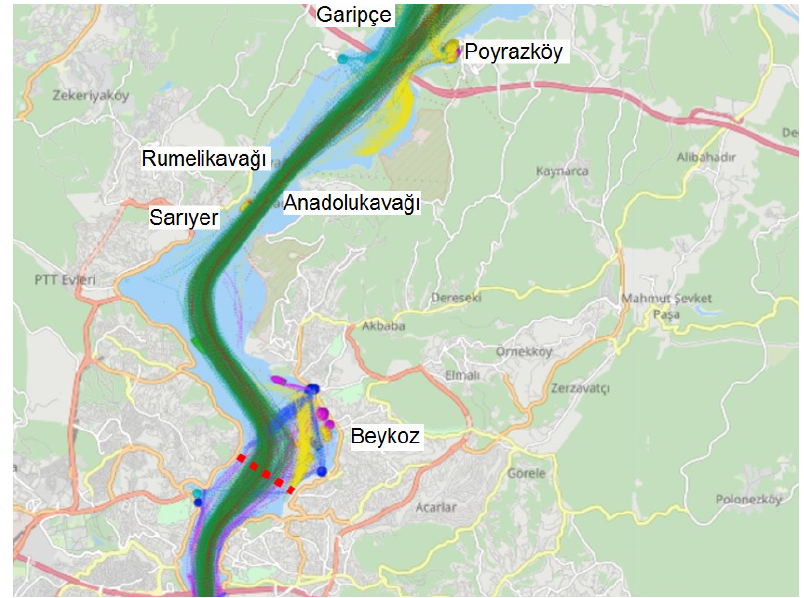
Figure 3. AIS tracks between 21 October 2021 and 26 October 2021 of different vessels in the portion of Istanbul Strait where purse seine fishing allowed (the dashed red line indicates that purse seine fishing is allowed in the north of this line). Green, red, yellow, blue, and purple tracks indicate cargo ships, tankers, fishing vessels, passenger ships, and other vessel types, respectively (Source https://www.myshiptracking.com/, accessed on 27 October 2021).